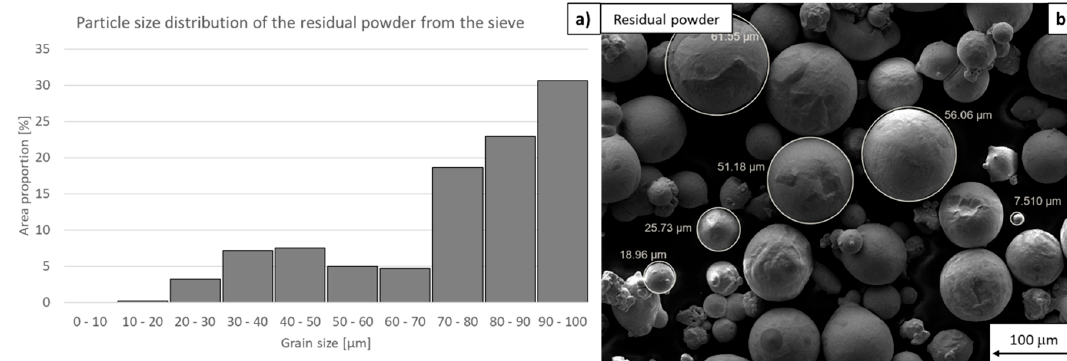
Figure 13. Residual oversize powder from the sieve. ( a ) Particle size distribution (using ImageJ software, 130 particles were measured for statistical significance), ( b ) tentative particle size measurement in an SEM image using SmartTiff software.